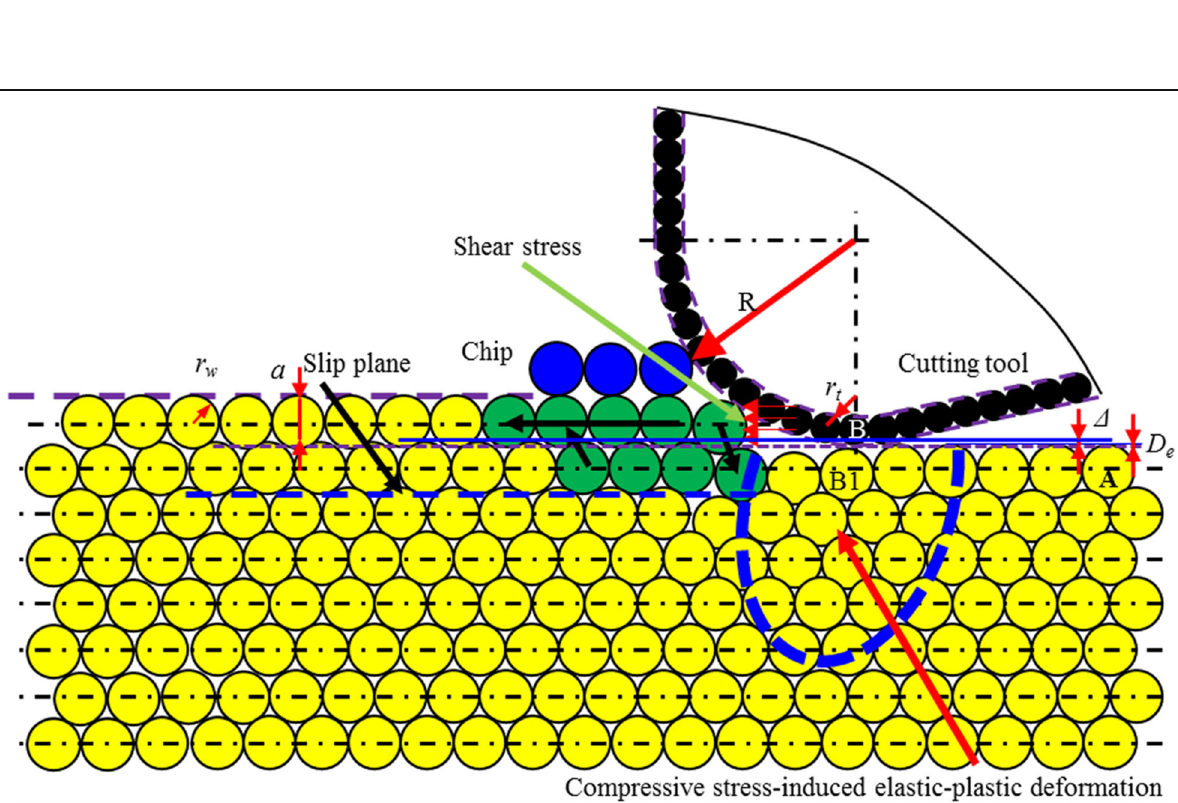
Fig. 19 Schematic illustration of cutting-based single atomic layer removal at a/r larger than C 2 and a/R lower than T 2